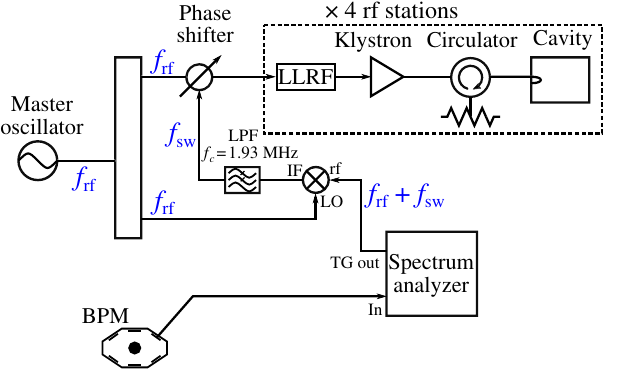
FIG. 9. Experimental setup for measuring the beam responses to the rf phase